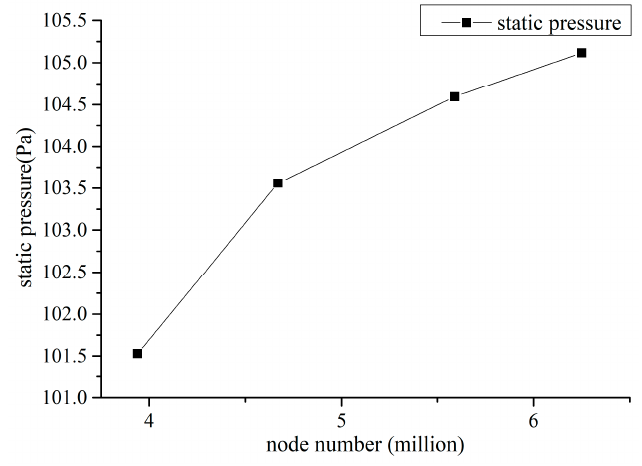
Figure 5. Validation of static pressure rise with node number.